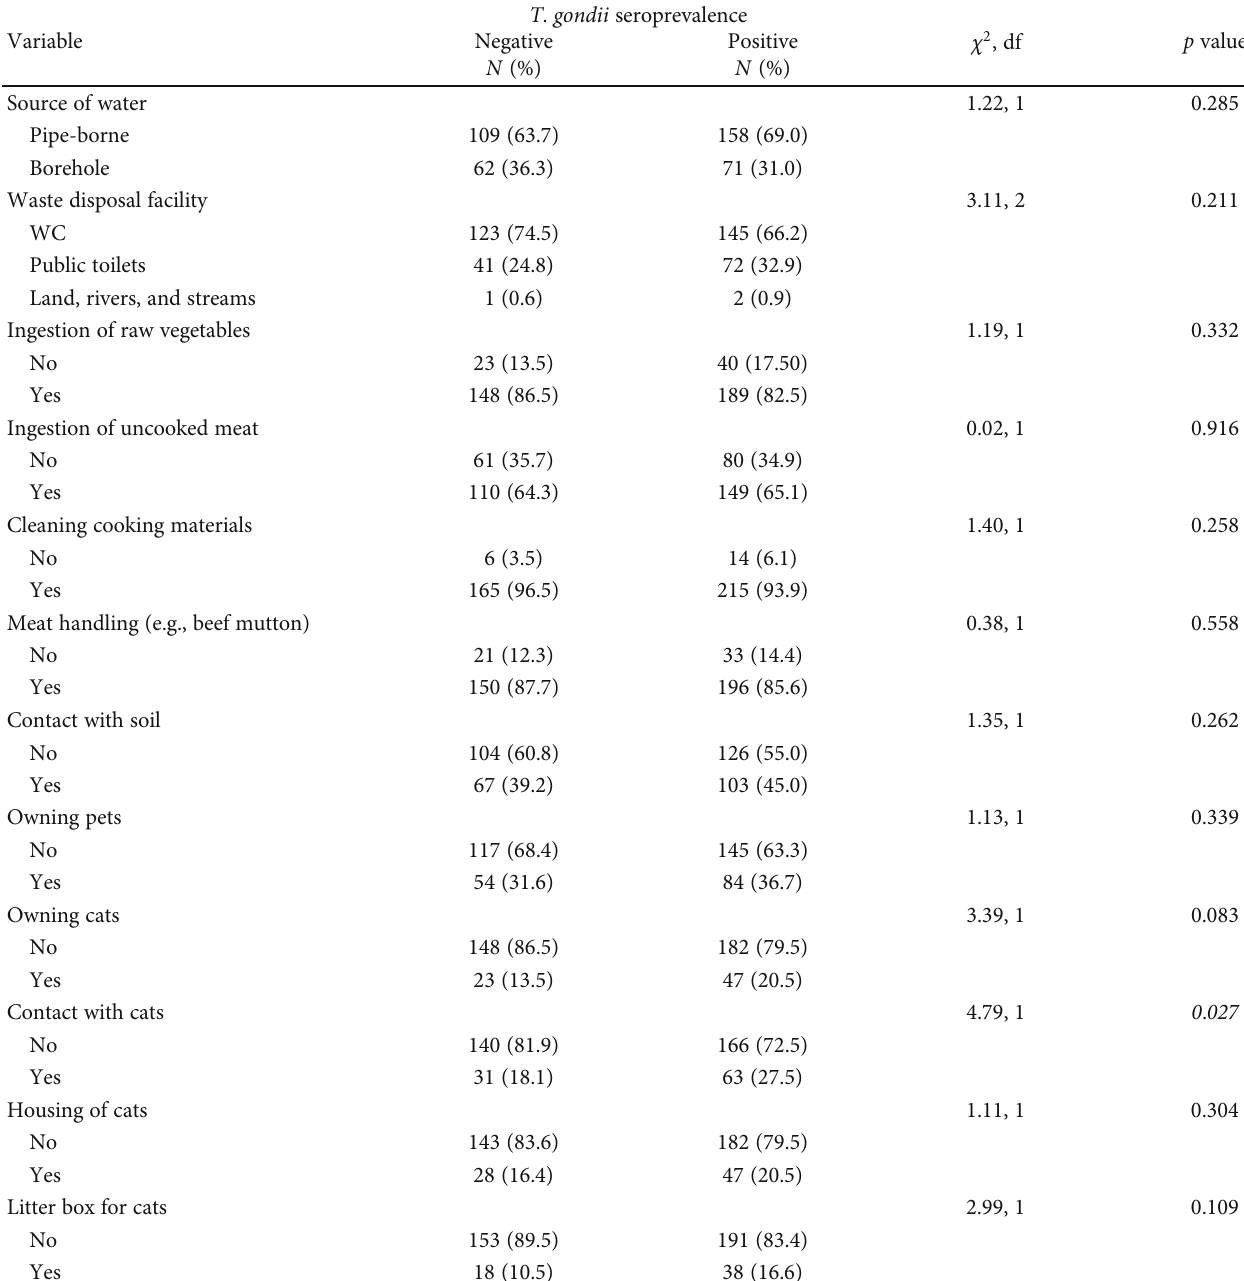
Table 2: Hygienic predisposing factors and Toxoplasma gondii